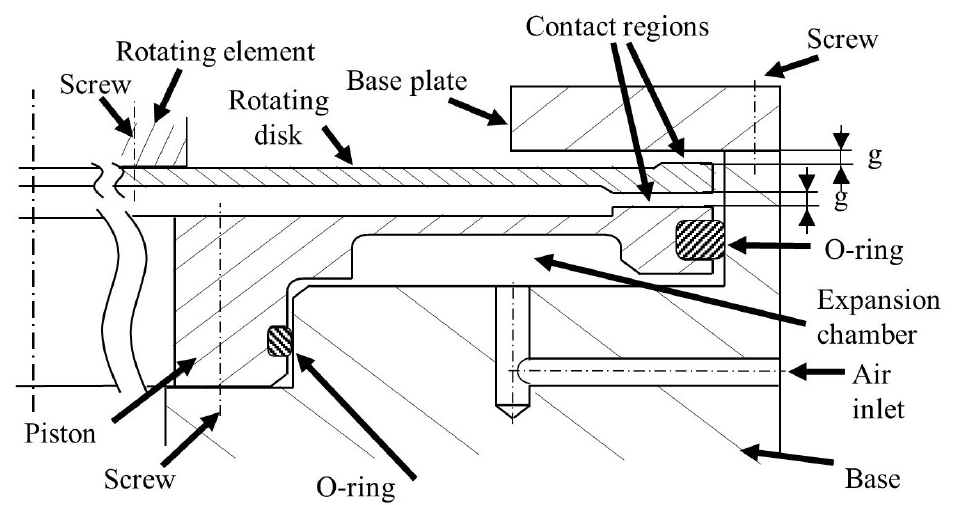
Figure 1. Schematic representation of the clamping system.